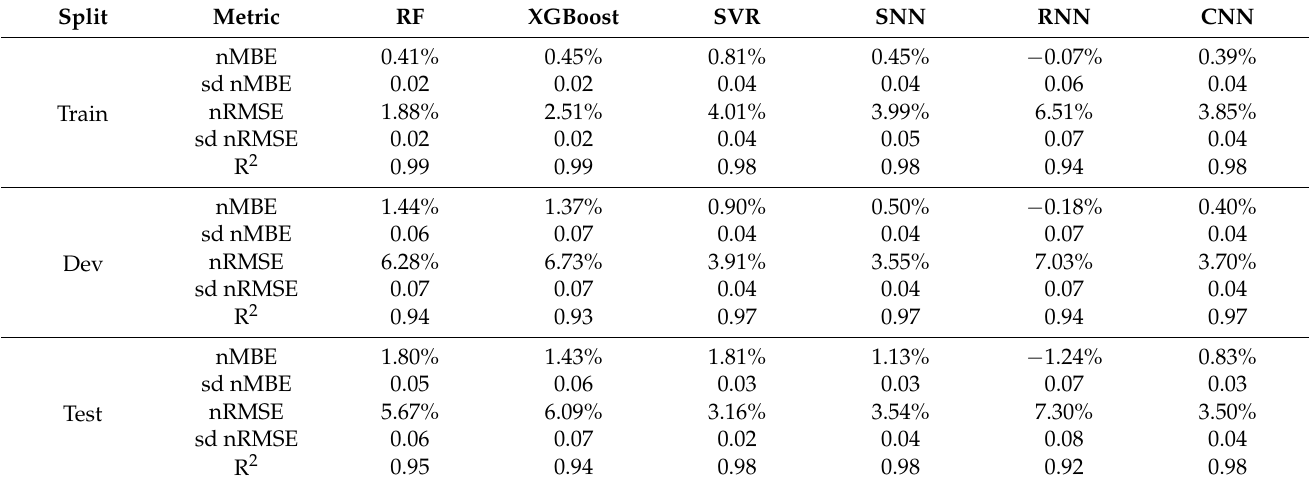
Table 1. Average error obtained with the cross-validation method in different Artificial Intelli- gence